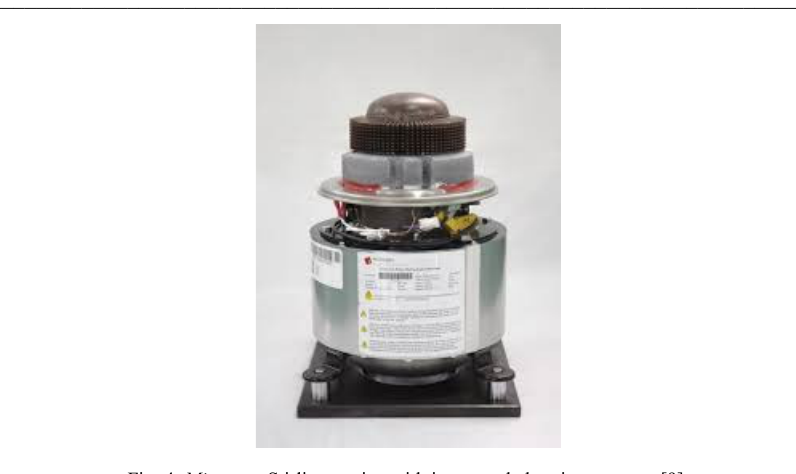
Fig. 4. Microgen Stirling engine with integrated electric generator [ 9].